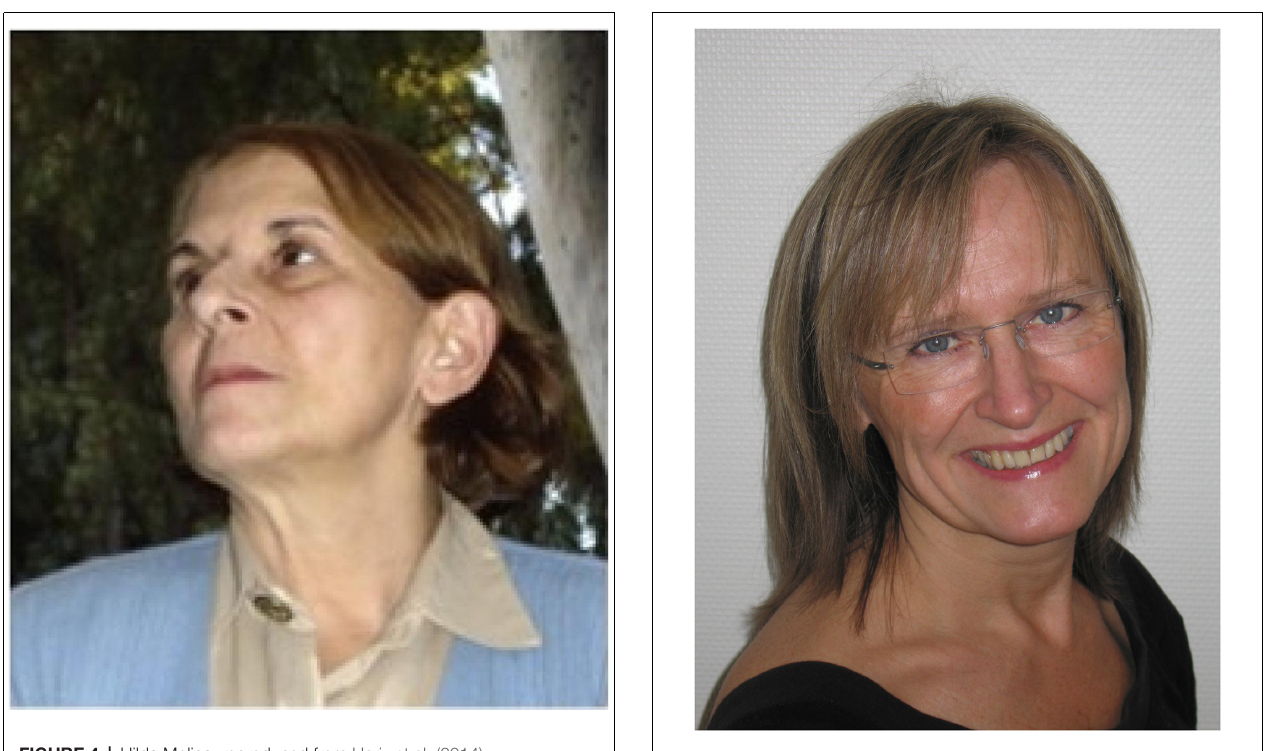
FIGURE 5 | Gun-Marie Hariz, provided by Gun-Marie